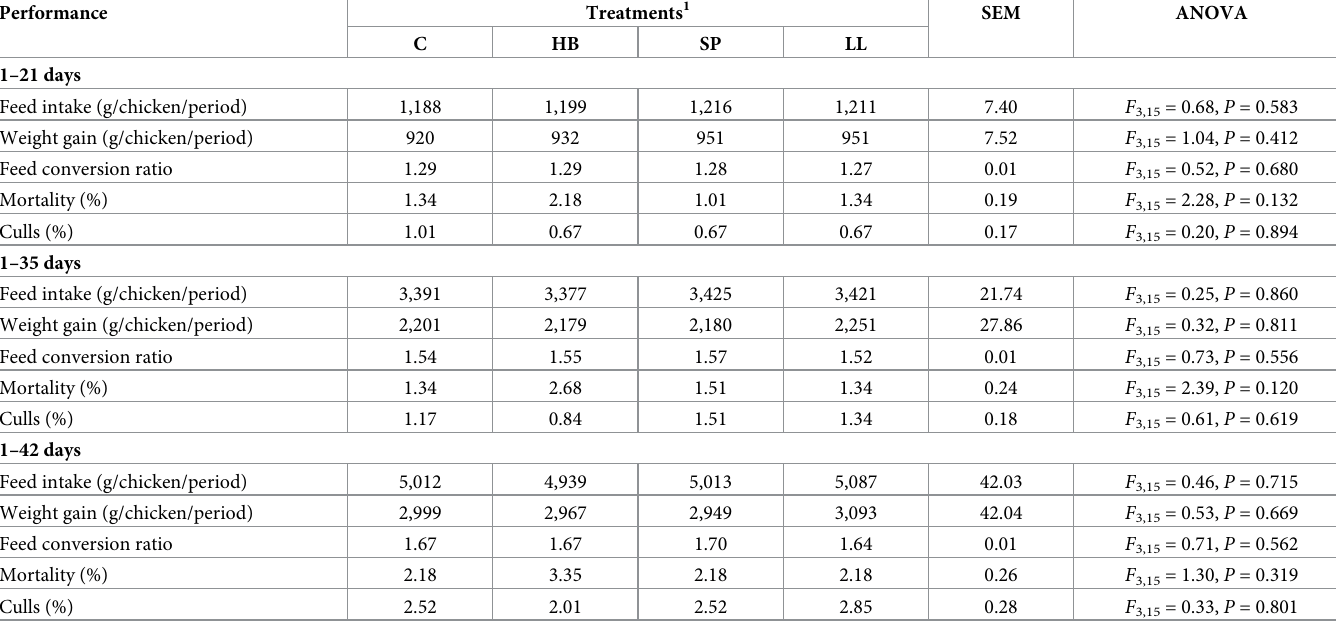
Table 2. Performance (mean ± SEM) of broiler chickens between days 1–21, days 1–35, and days 1–42 of rearing, n = 16.